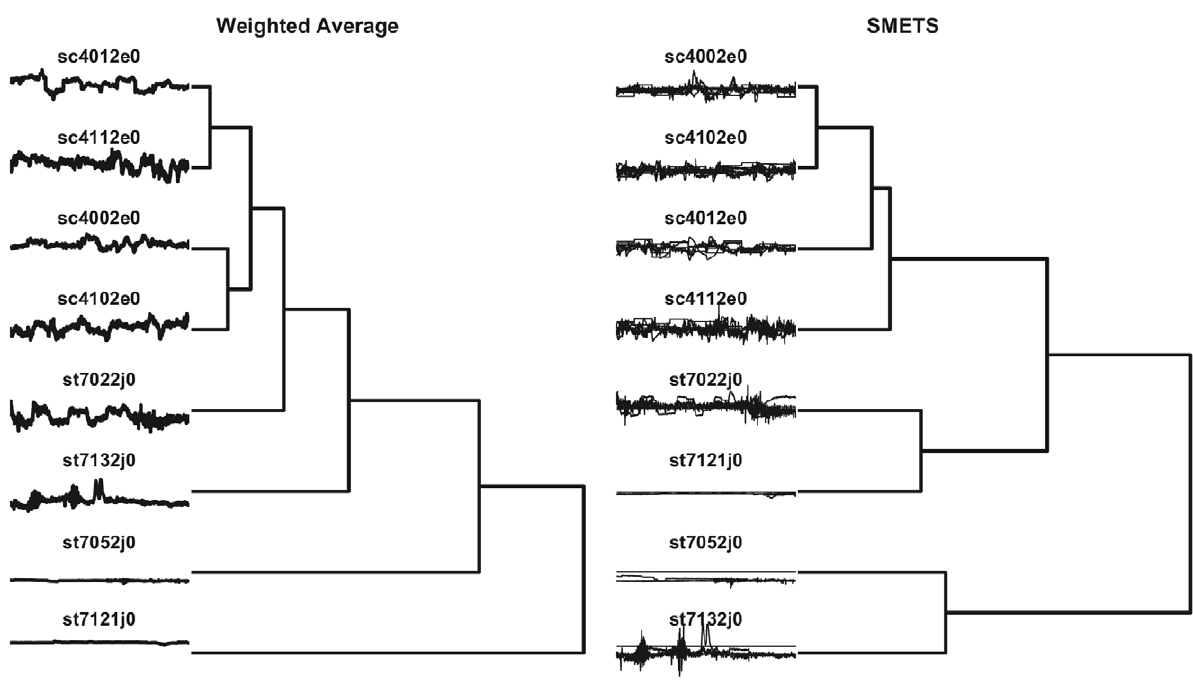
Figure 9. Hierarchical clustering of unmodified electrophysiological sleep data. Distances were measured using the weighted average method versus SMETS. The dendrogram reveals the relative distances between each entity. The time series considered by each method are represented to the left. Note that series sc4102e0, st7022j0 st7121j0 contain only 5 dimensions, while the other four contain 7 dimensions (see Results section for details).